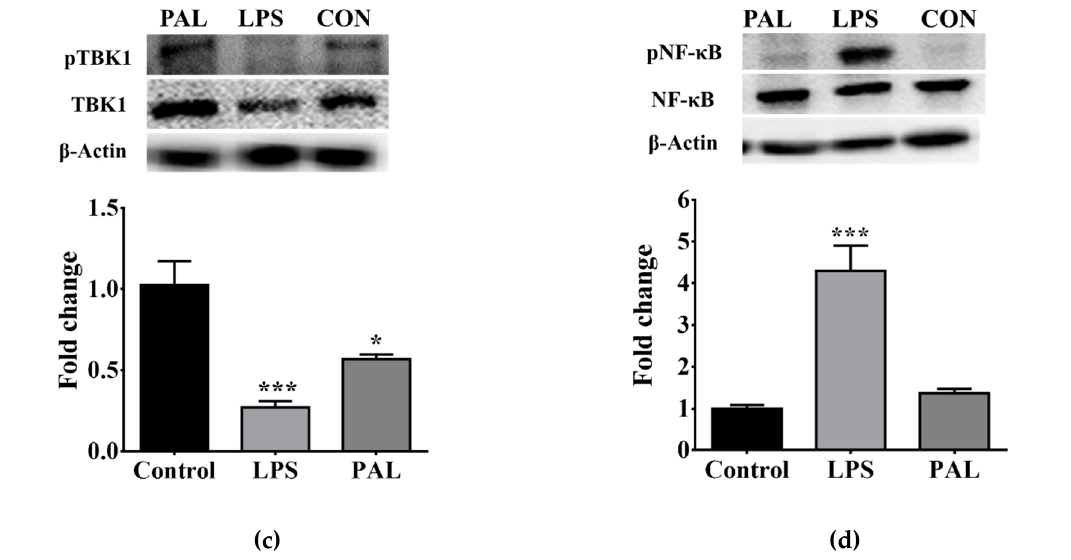
Figure 5. Palmitic acid promotes microglia activation and c-fos response in hypothalamus. Rats were i.c.v. administered with, ACSF, 2 µ g / µ L LPS or 40 µ g / µ L palmitic acid for 5 days and vehicle or ghrelin was injected into the third ventricle by day 5. Immunofluorescence against Iba-1 marker (microglia